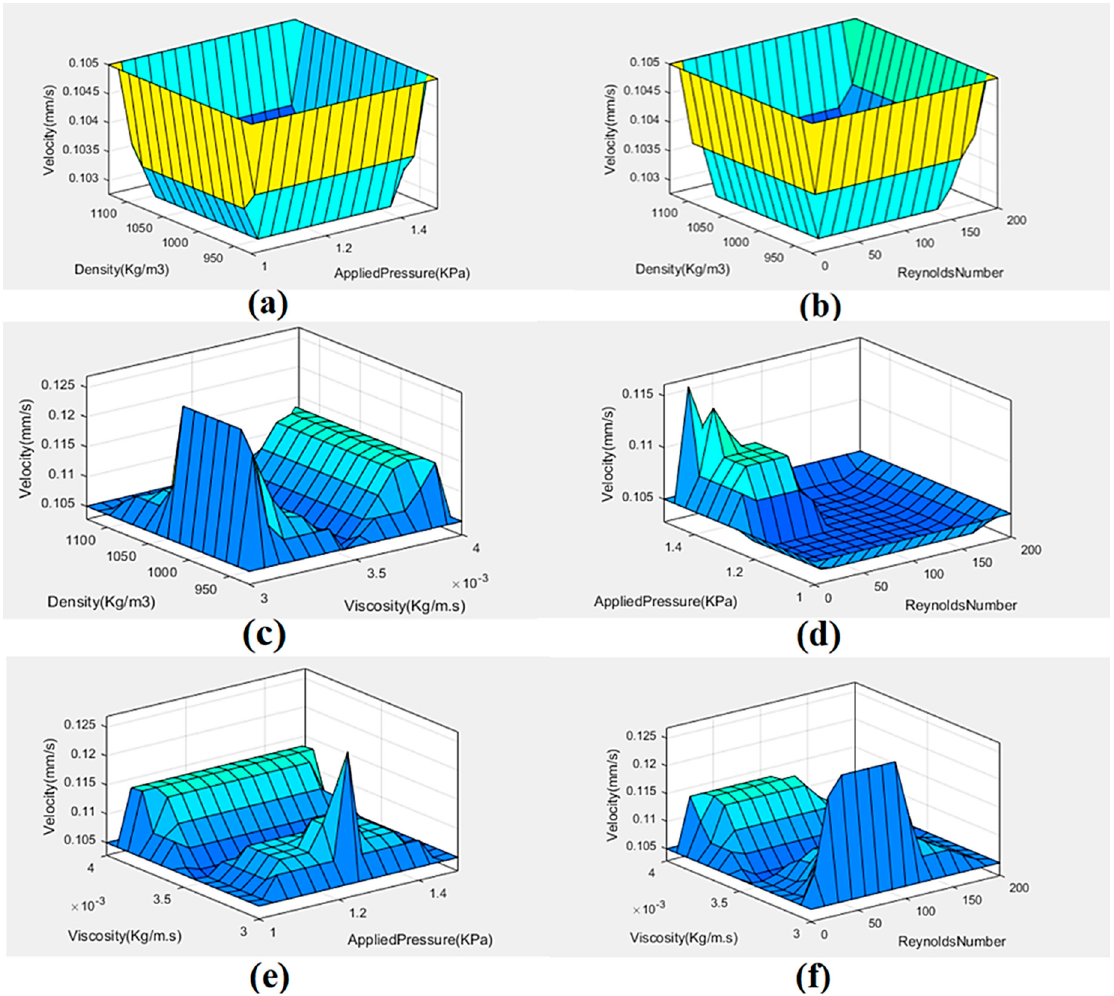
Figure 8. 3D graphical variations with inputs Reynolds number, applied pressure, viscosity, and density with flow rate as output ( a ) Variation for applied pressure with density and velocity as output ( b ) Variation for Reynolds number with density and velocity as output ( c ) Variation for viscosity with density and velocity as output ( d ) Variation for applied pressure with Reynolds number and velocity as output ( e ) Variation for applied pressure with viscosity and velocity as output ( f ) Variation for Reynolds number with viscosity and velocity as output. The three-dimensional graphs obtained for 5CDCMC from Fuzzy logic simulation with pressure drop as output are shown below in Figure